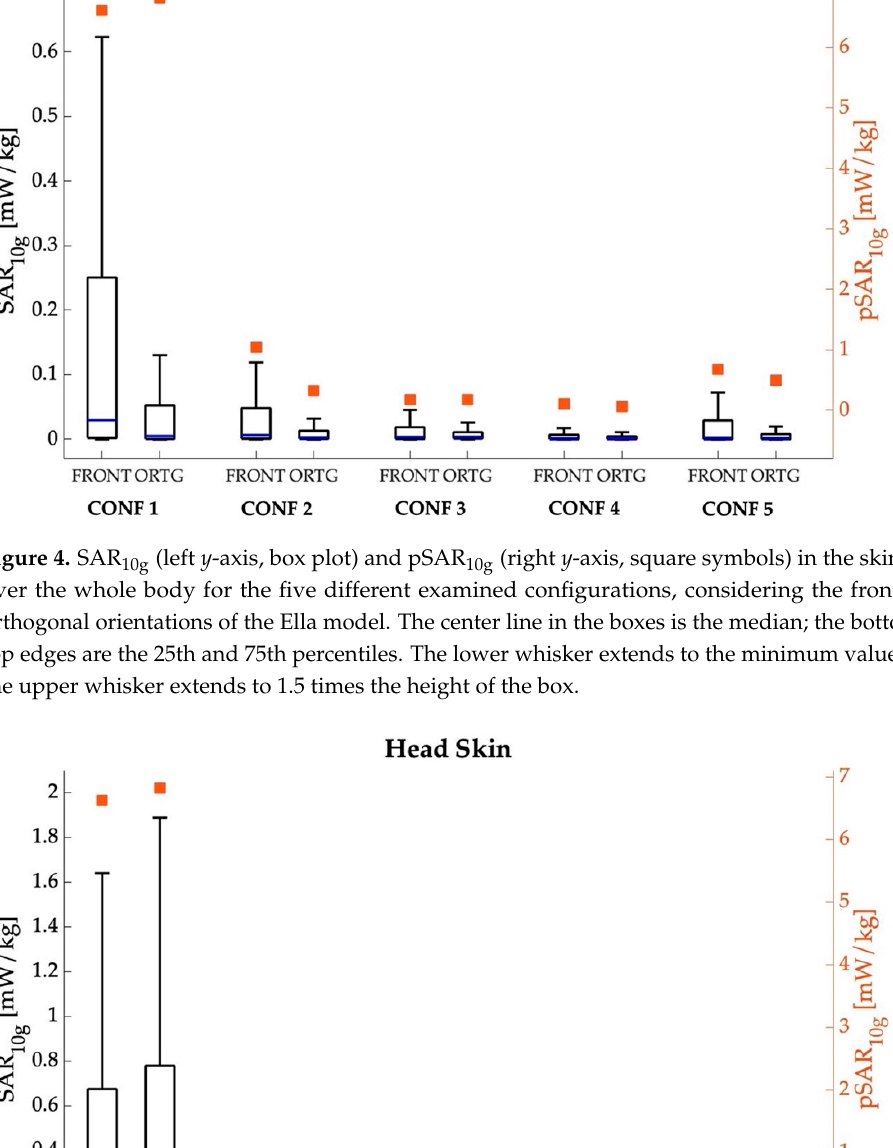
Figure 6. SAR 10g (left y -axis, box plot) and pSAR 10g (right y -axis, square symbols) in the brain tissue for the five different examined configurations, considering the frontal and orthogonal orientations of the Ella model. The center line in the boxes is the median; the bottom and top edges are the 25th and 75th percentiles. The lower whisker extends to the minimum value, while the upper whisker extends to 1.5 times the height of the box.